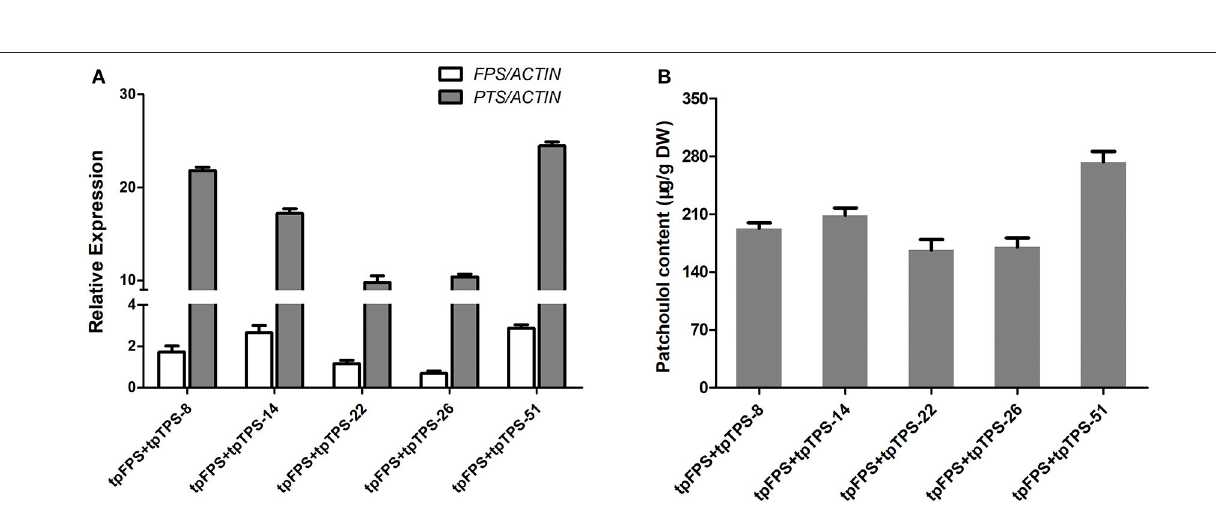
FIGURE 5 | Engineering the patchoulol biosynthesis in the chloroplast compartment increased the patchoulol content in tpFPS + tpPTS transgenic A. annua plants. (A) Relative expression of FPS and PTS in tpFPS + tpPTS transgenic A. annua lines. (B) The patchoulol content in tpFPS + tpPTS transgenic A. annua lines. ACTIN was used as internal control. The error bars represent the means ± SD from three biological